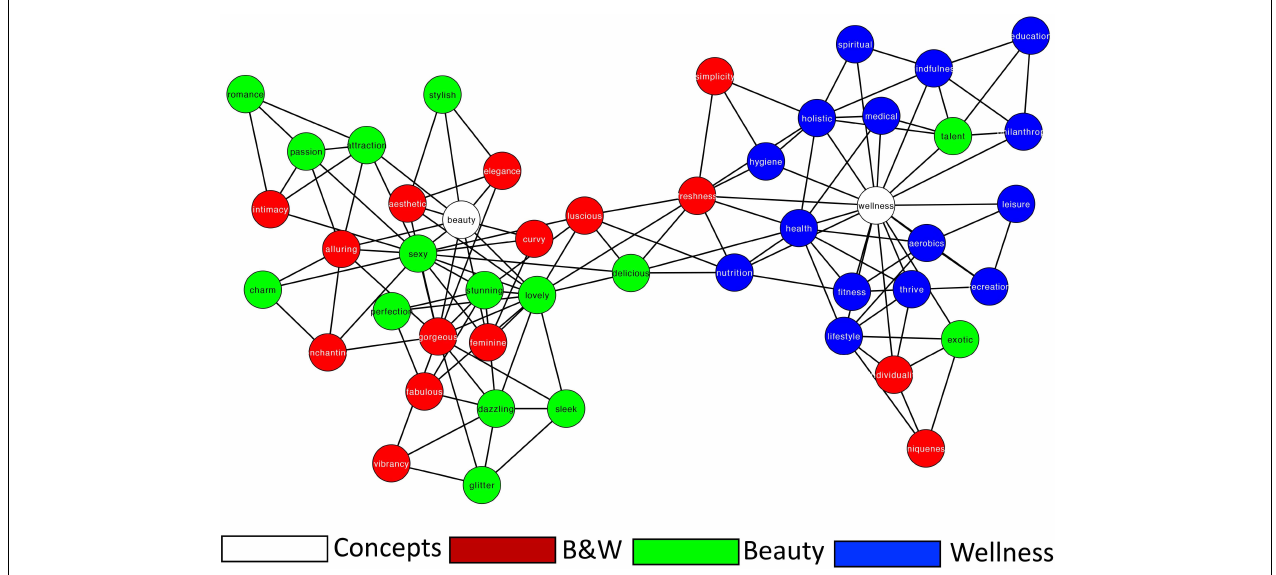
FIGURE 1 | 2D visualization of the 47 cue words (nodes) semantic networks. Edges denote symmetrical, binary relations between nodes. Colors represent category membership.